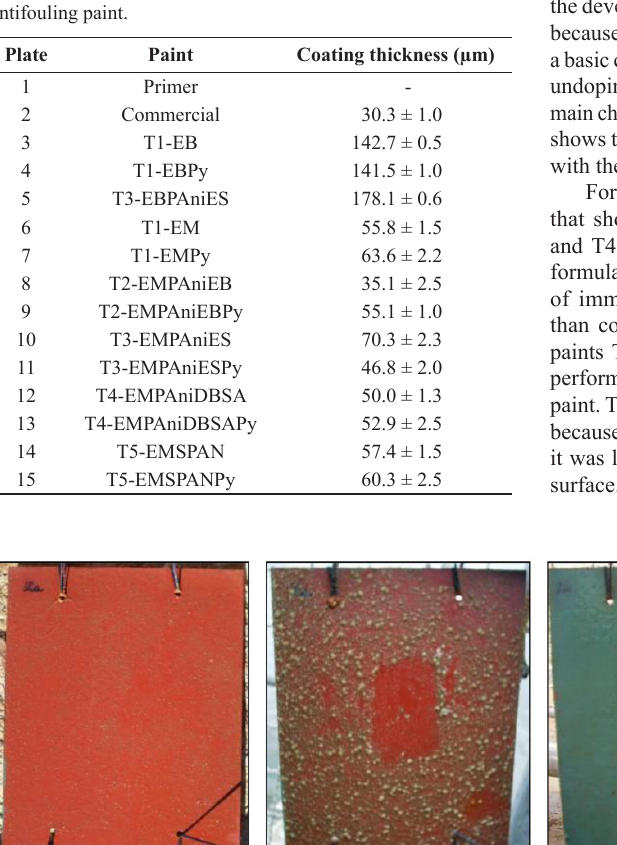
the Balanus incrustation in the fourth week of immersion.